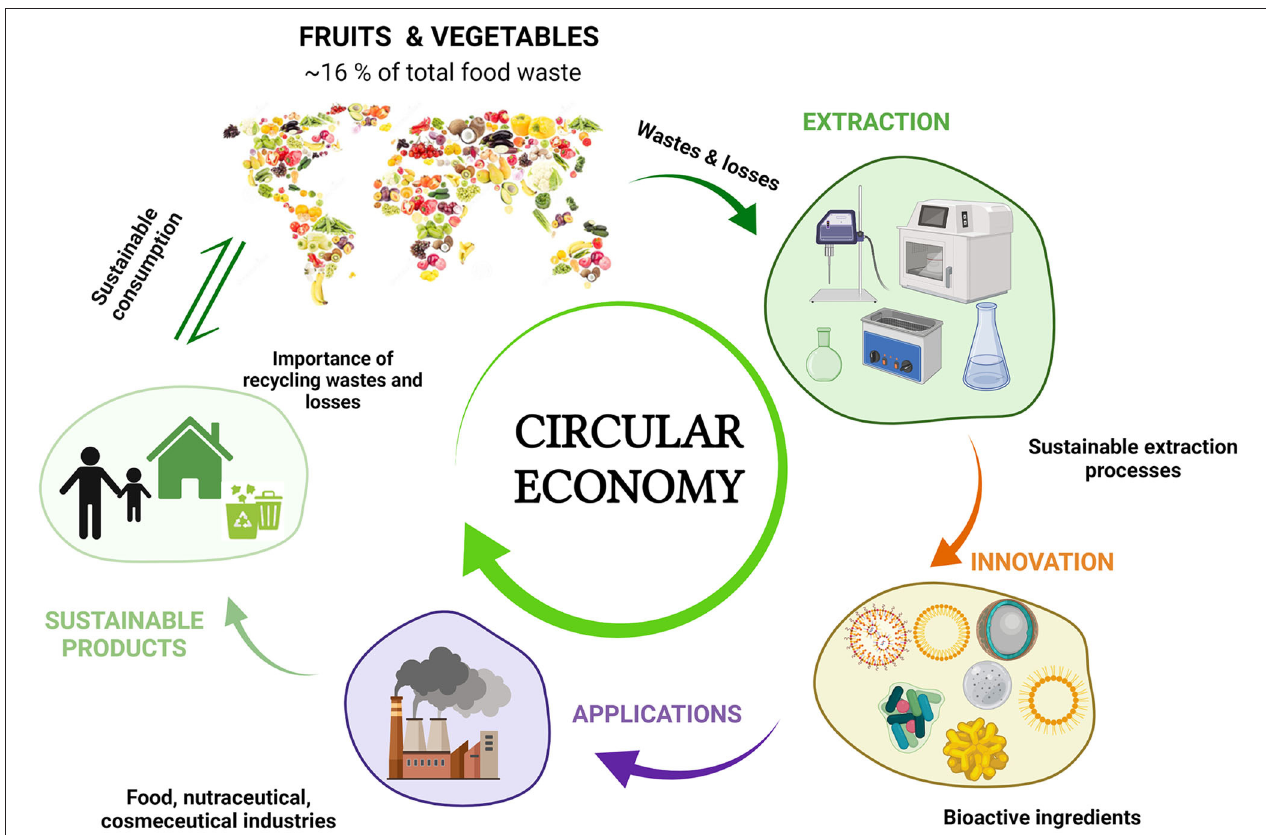
FIGURE 2 | Suitability of valorization of fruits and vegetables within the scope of the Circular Economy